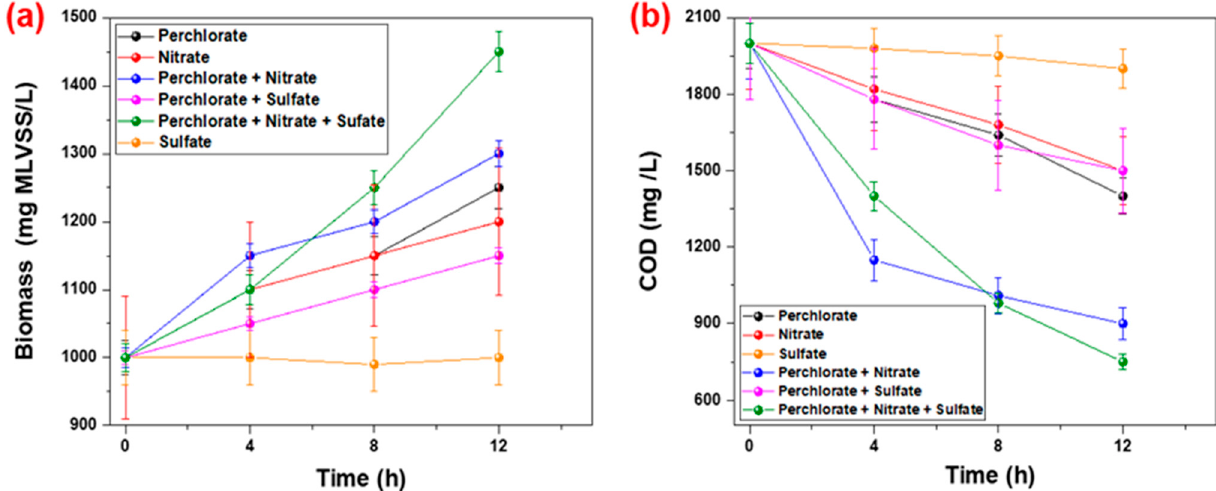
Figure 2. Biomass and COD variation under the influence of various electron acceptors. ( a ): Biomass concentration (mg MLVSS/L); ( b ): COD variation (mg/L) (error bar represents the SD with a reading of 3 with maximum SD: